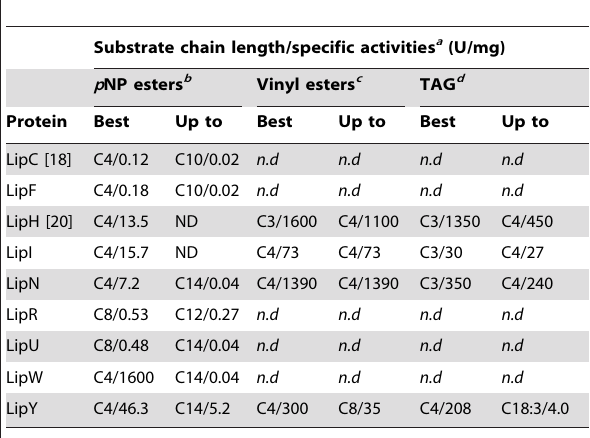
Table 1. Substrate specificity of recombinant Lip-HSL proteins.